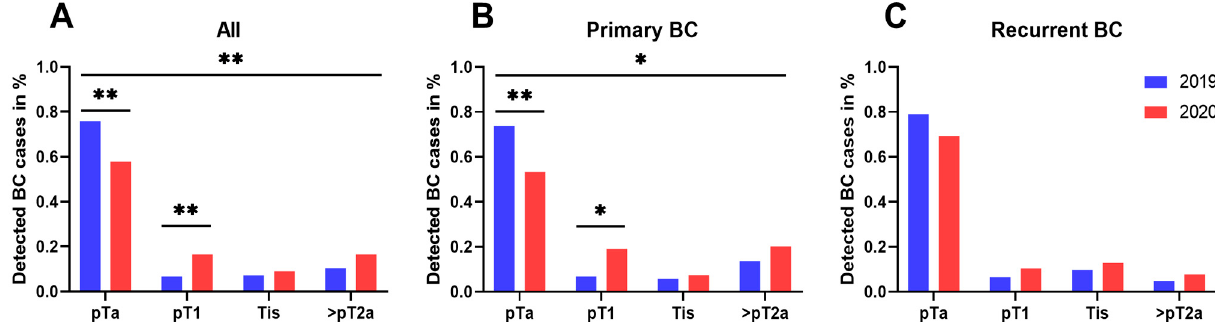
Figure 3. Tumor staging compared between 2020 and 2019. ( A ) total BC population ( n [2019] = 165; n [2020] = 133), ( B ) patients with primary bladder cancer ( n [2019] = 103; n [2020] = 94), and ( C ) patients with recurrent BC during oncological follow-up ( n [2019] = 62; n [2020] = 39). * p < 0.05; ** p < 0.01.